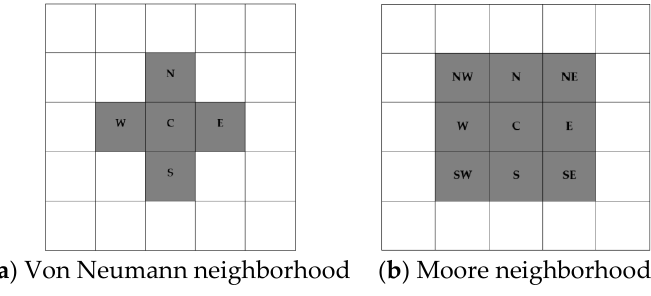
Figure 1. Neighborhood structures.